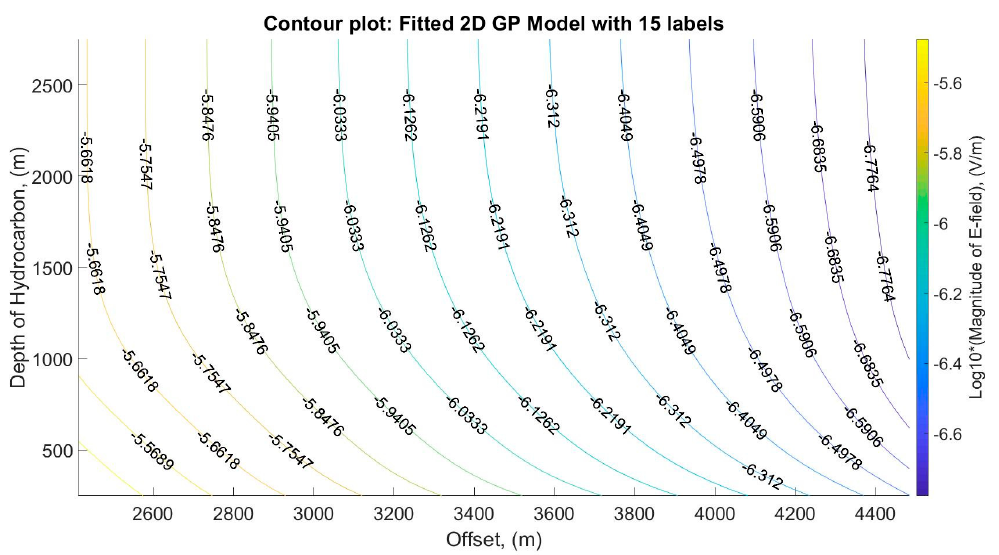
Figure 7. Contour plot of EM profiles (amplitude) for various offset distances (~2400 to ~4500 m) and hydrocarbon depths (250–2750 m) at a frequency of 0.125 Hz with 15 labels.